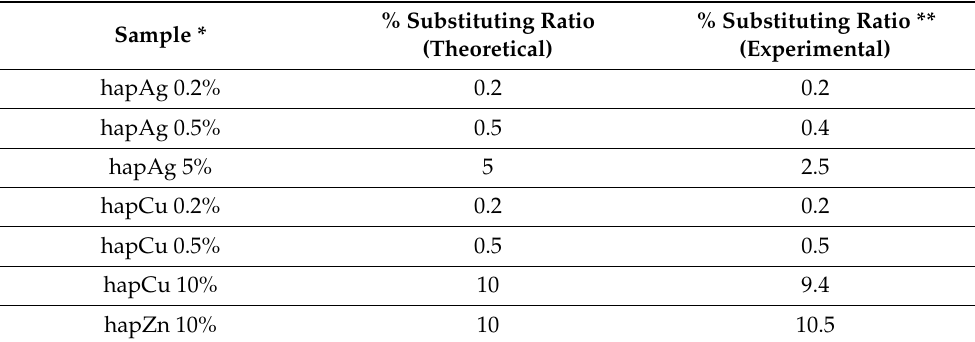
Table 1. Listing of biomimetic apatite samples and substituting rates studied in this work, with theoretical and experimental substituting